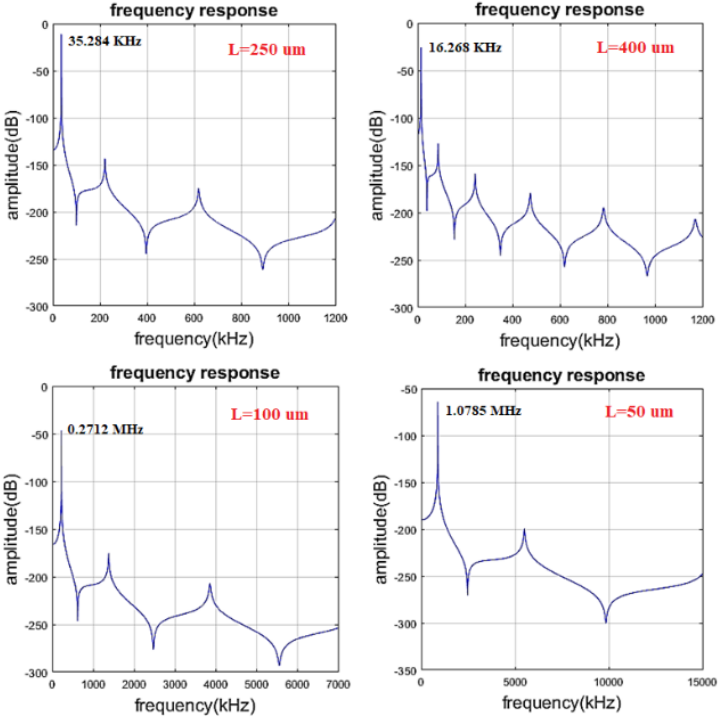
Figure 7. The frequency responses calculated with TSBT method for microcantilevers with W = 50 µm, T = 2 µm and L = 50, 100, 250 and 400 µm.